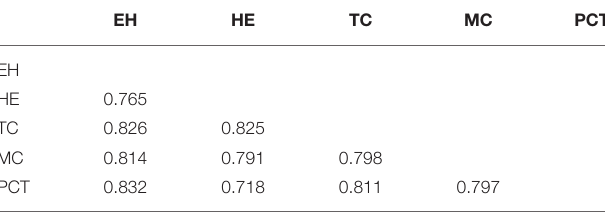
TABLE 5 | Discriminant validity (Fornell and Larcker Criteria).